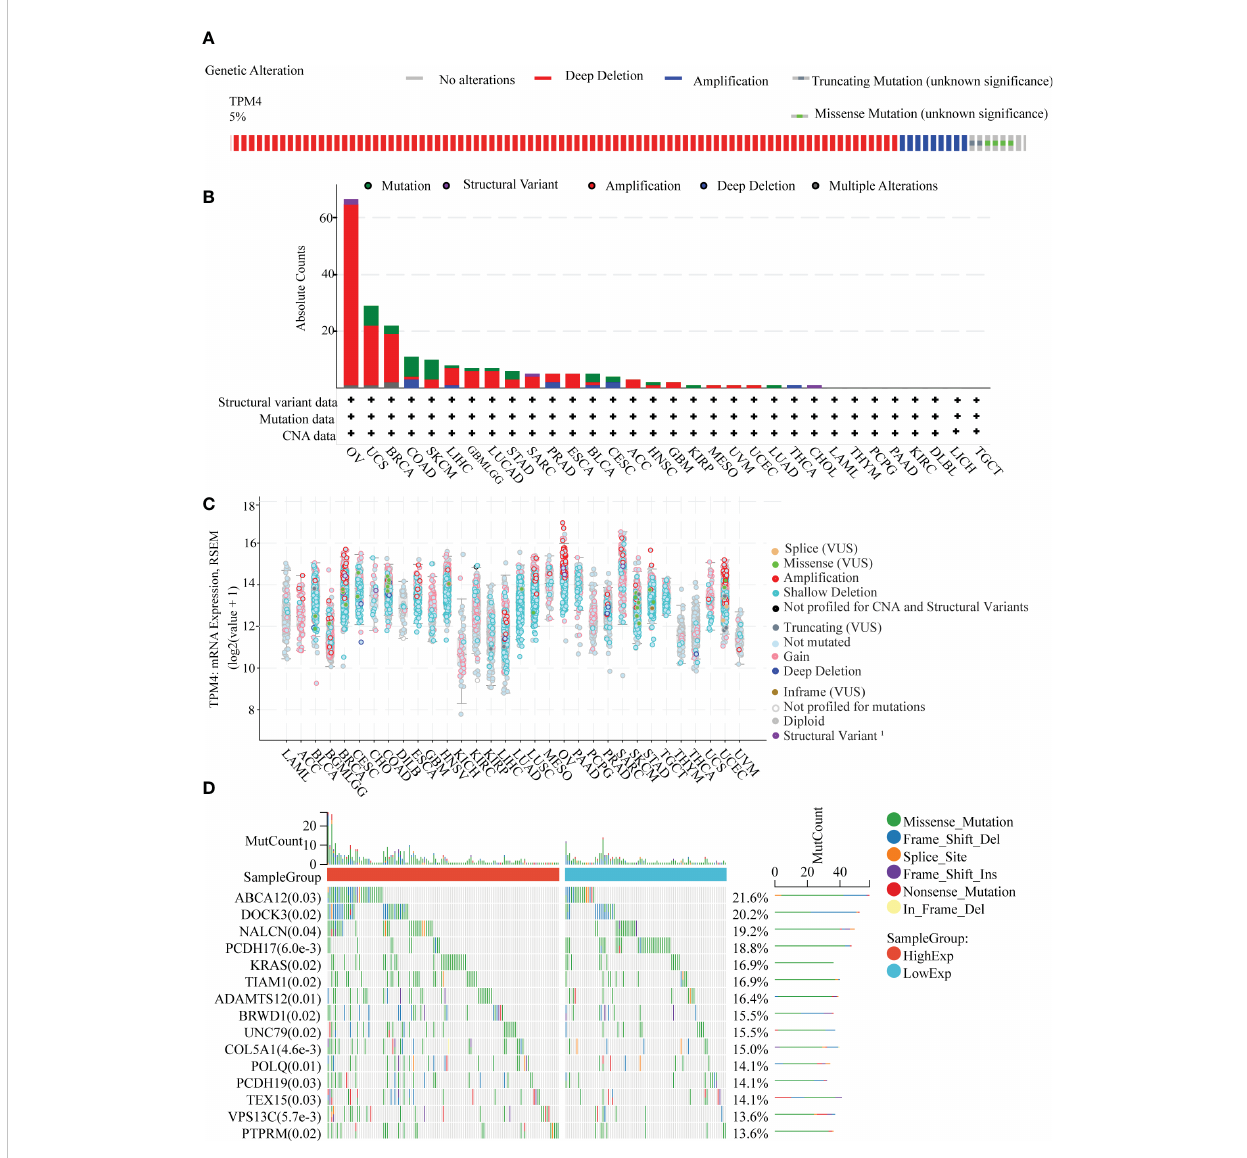
FIGURE 4 Genetic alteration analysis. (A) Genetic alteration in TPM4 in pan-cancer tissues, accounting for 5% of alterations (altered/pro fi led = 131/2565). (B) The alteration frequency with the mutation type of TPM4 in different cancers (C) . The mRNA expression of TPM4 putative copy-number alteration (CAN) in pan-cancer tissues (D) . The top 15 genes with the highest frequency of mutations in the high TPM4 expression group and low TPM4 expression group in